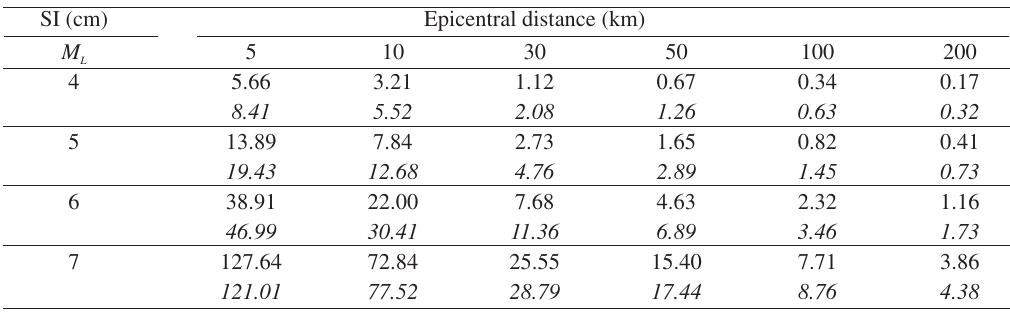
Table IV. Values of response spectrum intensity (SI, in cm) for rock sites, using the PSV attenuation relationships ZM02 and SP96 (numbers in italics correspond to SP96). SI (cm) Epicentral distance